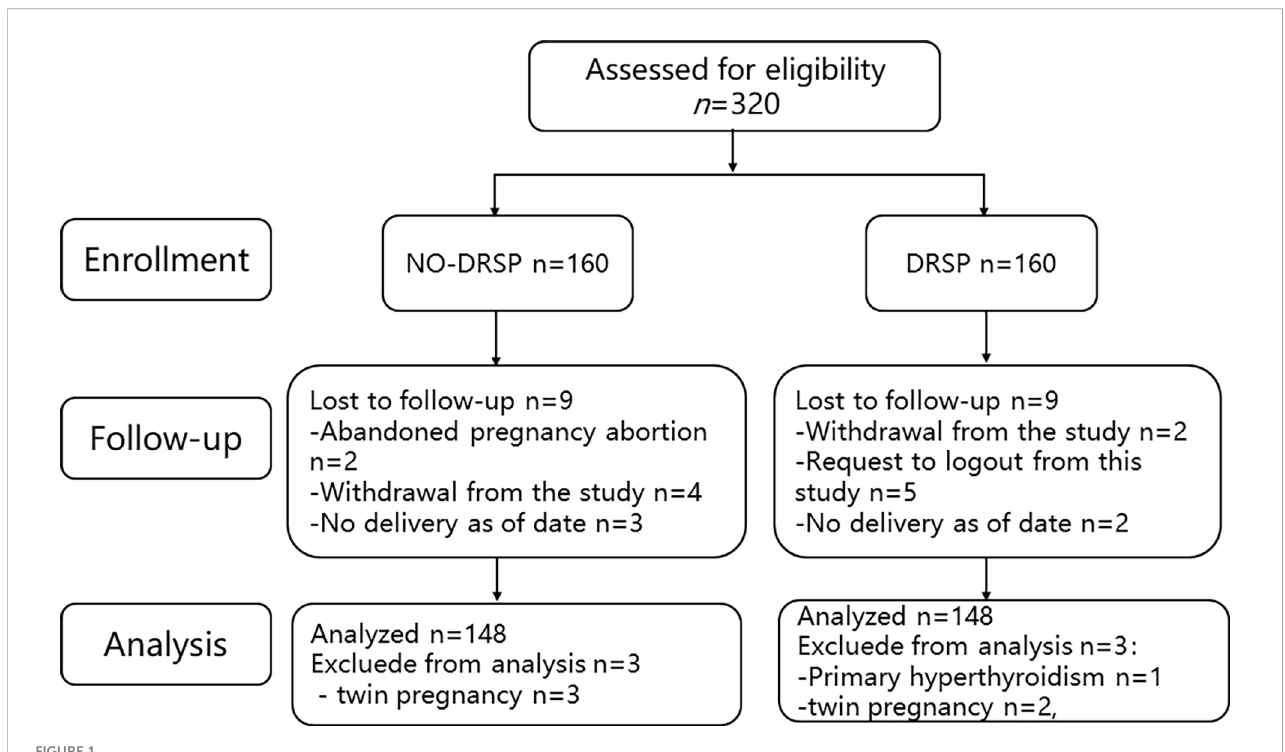
FIGURE 1 Flow chart of patient registration and